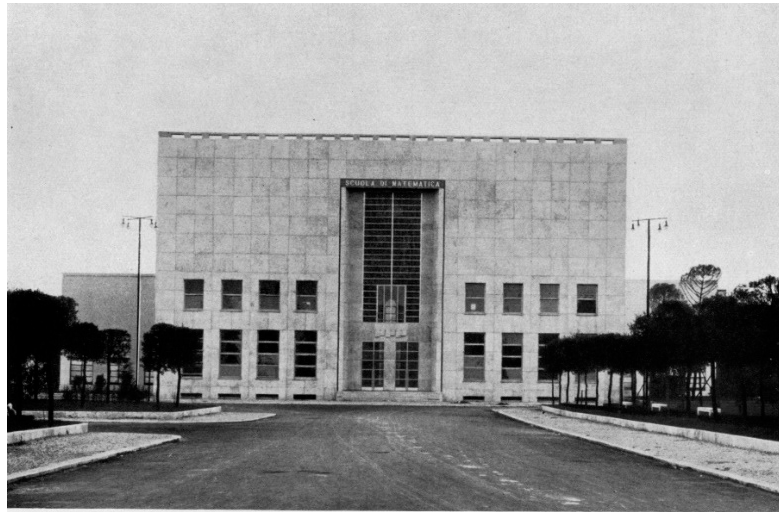
Figure 29. The Institute of Botany by Giuseppe Capponi. Photo from (Baliviera et al. 1935, p. 65).